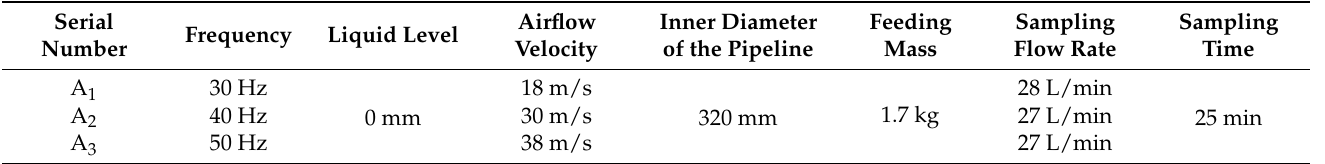
Table 4. Dust sampling conditions at the experimental site.